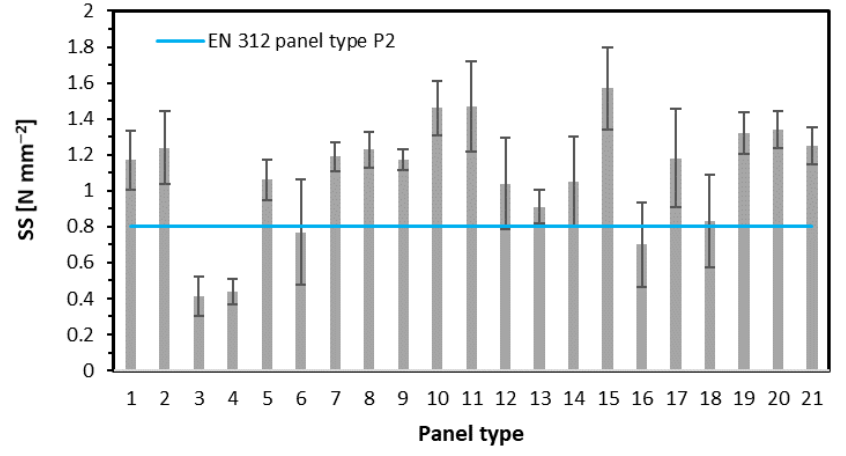
Figure 7. The surface soundness of tested panels.